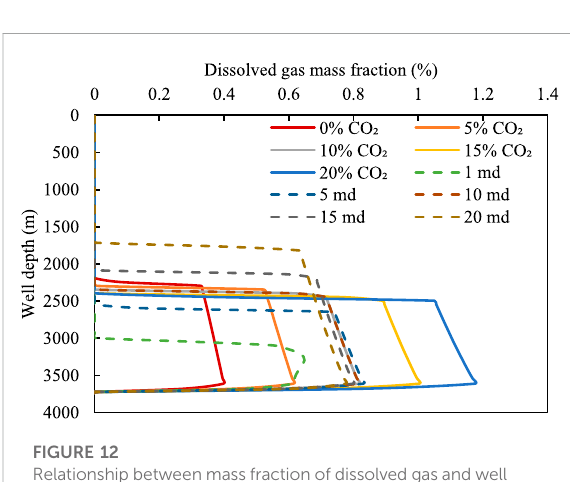
FIGURE 12 Relationship between mass fraction of dissolved gas and well depth for different intrusive gases and